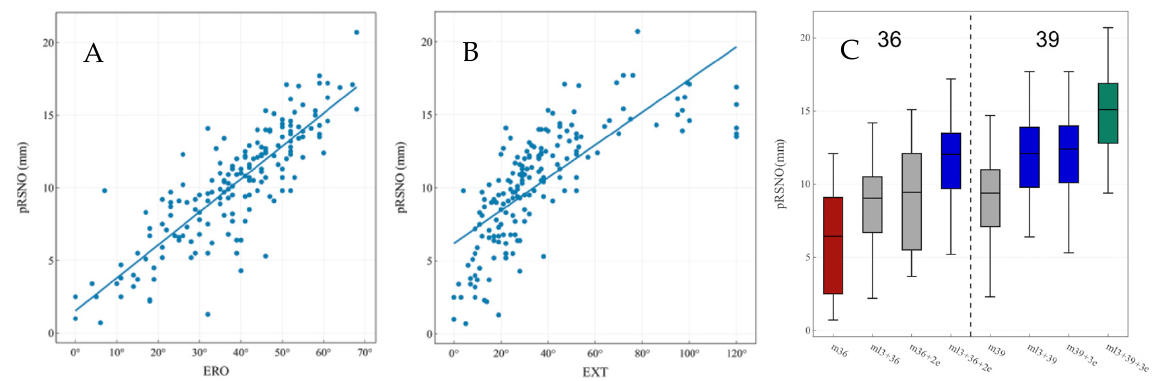
Figure 3. ( A ) Correlation between pRSNO and ERO. ( B ) Correlation between pRSNO and EXT. ( C ) Effect of glenosphere type on pRSNO. Figure reused with permission from the article of Bauer et al. [18]. aRSNO: anteroinferior relevant scapular neck offset; pRSNO: posteroinferior relevant scapular neck offset; ERO: external rotation; EXT: extension.